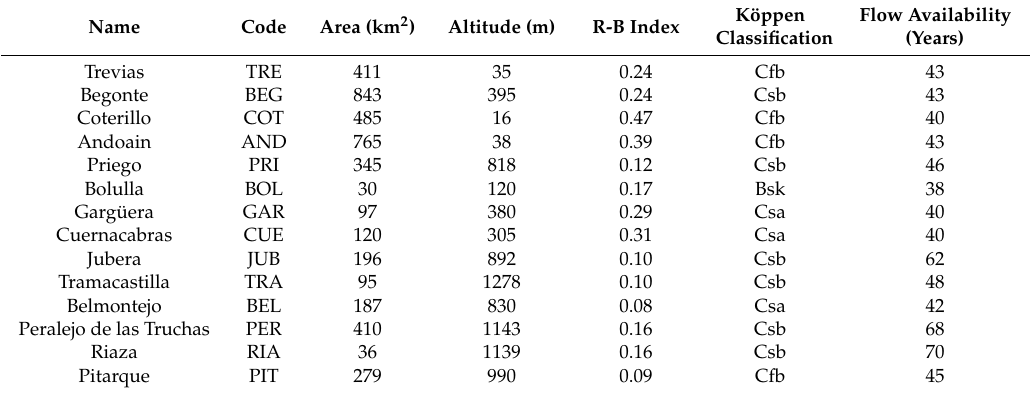
Table 1. Summary of the main characteristics of the selected